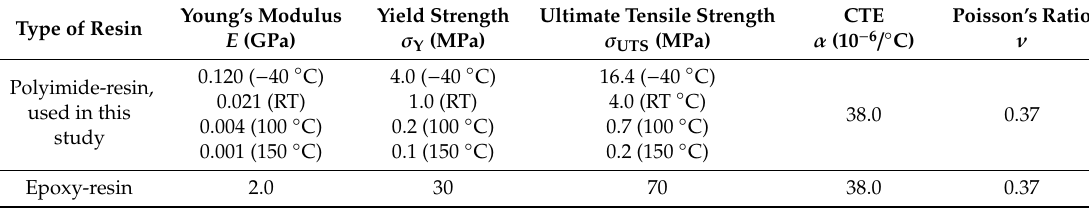
Table 3. Physical properties of resin used in FE